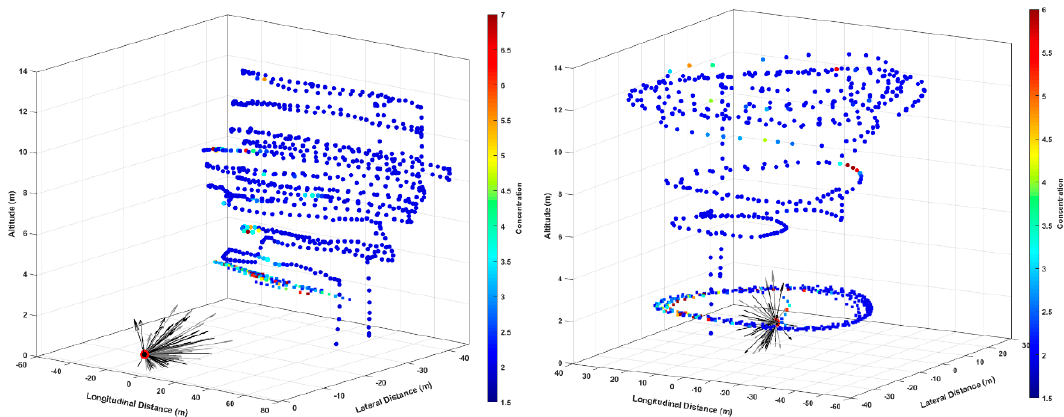
Figure 8. Geo-located methane concentration data from sUAS sensor from two flights. In both panels, the emission point is shown as a red circle (at altitude zero) with a time-series of wind vectors.